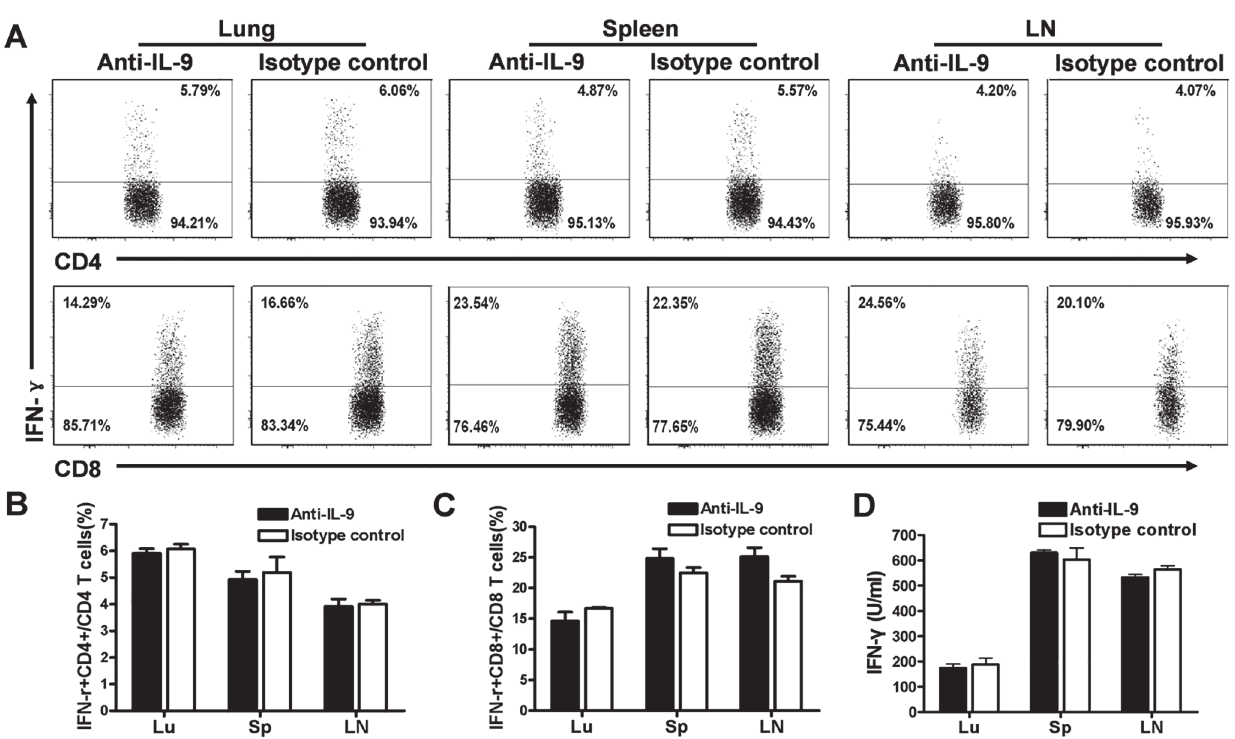
Fig 5. In vivo neutralization of IL-9 failed to alter IFN γ producing by CD4+ and CD8+ T cells following Cm lung infection. C57BL/6 mice (4 mice per group) were treated with anti-IL-9 mAb or isotype control antibody at days -1, 0, 2, 4 and 6 following intranasal infection with Cm (1×10 3 IFUs) and sacrificed at day 7 after infection. (A) Representative data of IFN- γ -producing CD4+ and CD8+ T cells in each group. (B) & (C) Summary of the percentage of IFN- γ + CD4+ T cells and IFN- γ + CD8+ T cells in each group (4 mice/group in each experiment). (D) Lung, spleen and draining LN cells were isolated and cultured with UV-inactivated EBs. The concentrations of IFN- γ in the culture supernatants were measured by ELISA. One representative experiment of three independent experiments (4 mice in each group) with similar results is shown. Data are shown as the mean ± SD.